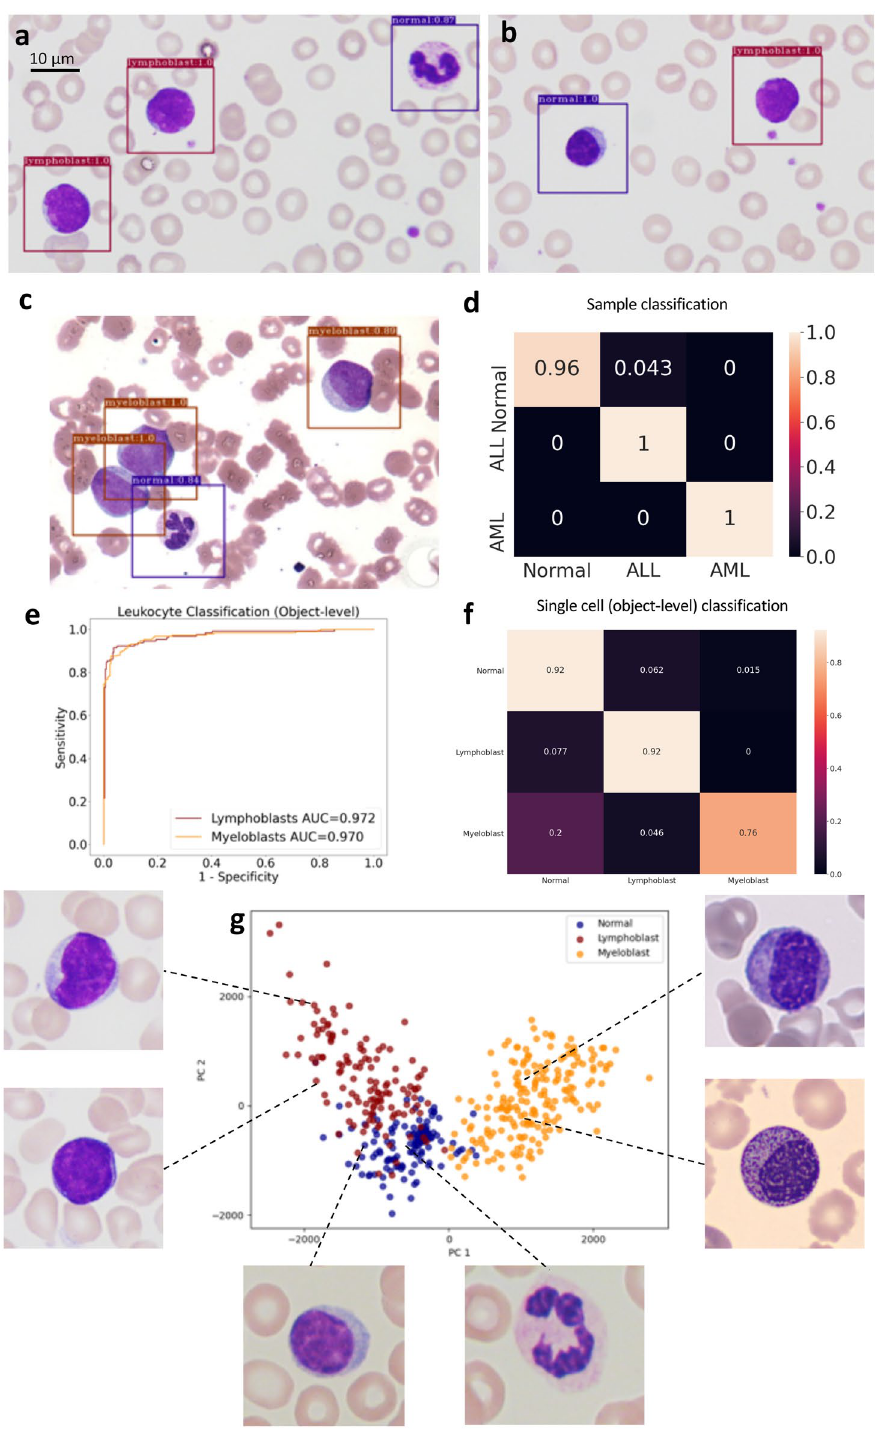
Figure 2. Acute leukemia detection and typing in blood films. ( a, b ) Normal WBC and lymphoblasts detected in two ALL positive sample from the hold out validation set. ( c ) Normal leucocytes and myeloblasts detected by MILLIE in an AML sample. ( d ) Confusion matrix for sample classification on the validation set. ( e ) Receiver operating characteristic (ROC) curve for single cell classification on the cell image test set. ( f ) Confusion matrix for cell classification (lymphoblasts vs myeloblasts vs normal) on the cell image test set. ( g ) PCA visualization of the convolutional representations learned by MILLIE of the individual cells in the test